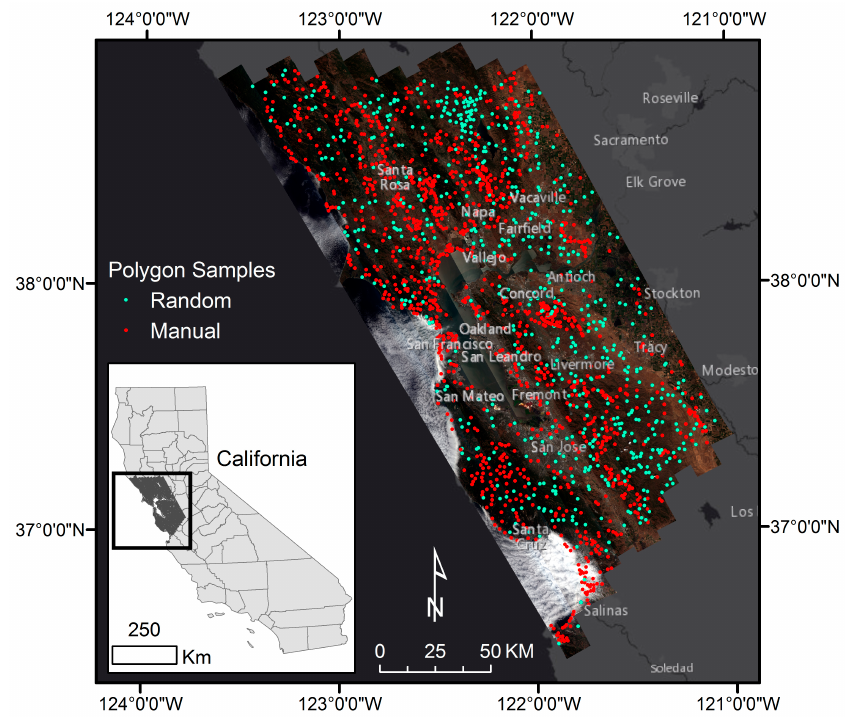
Figure 1. Study area overview with an AVIRIS-C, 11 June 2015 RGB mosaic of 12 individual flight runs. Reference data are red and cyan points. Inset shows the multi-seasonal image extent with water and cloud mask applied. Table 1. Summary of San Francisco Bay Area AVIRIS-C images for the year